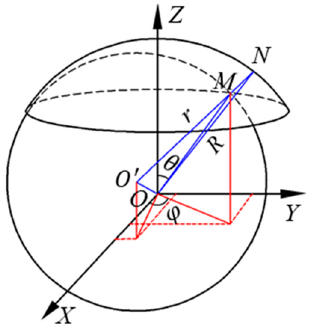
Figure 3. Sketch of the clearance between the ball and the sensing plates.